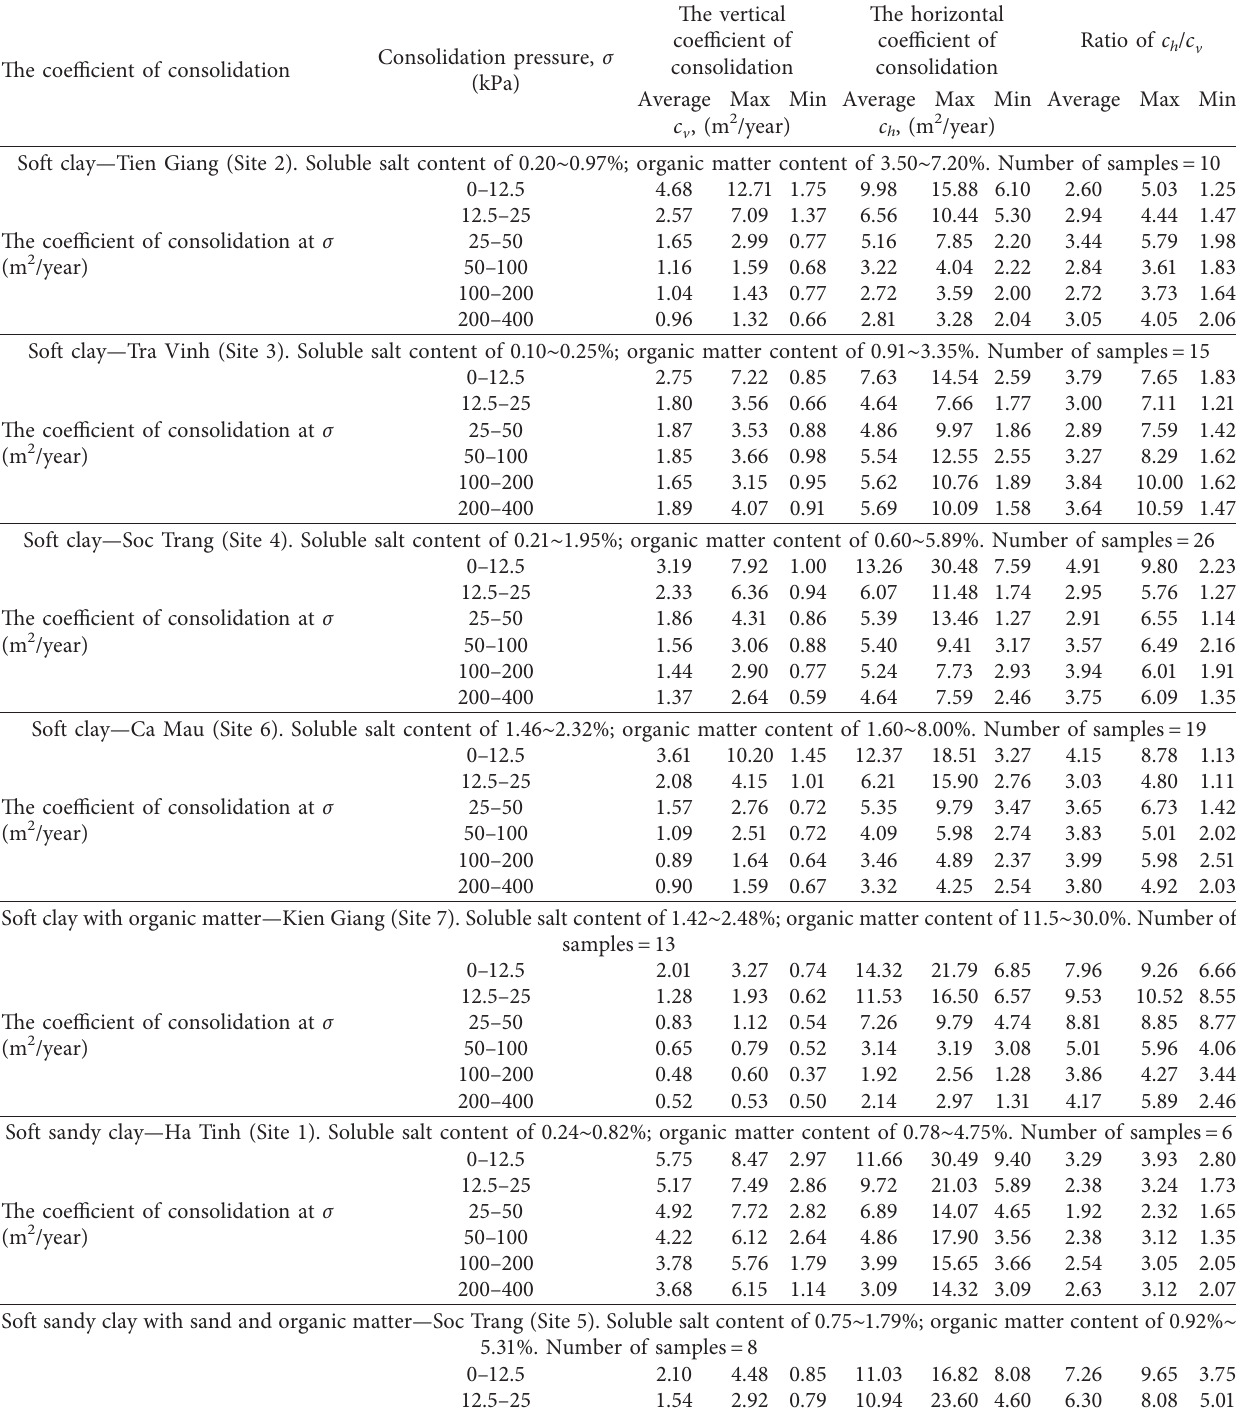
Table 2: The consolidation properties of soft soil at different sites in